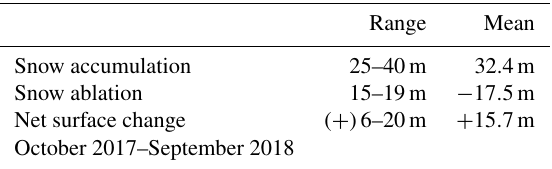
Table 3. Mean and range of snow accumulation, ablation and net surface change October 2017–September 2018.